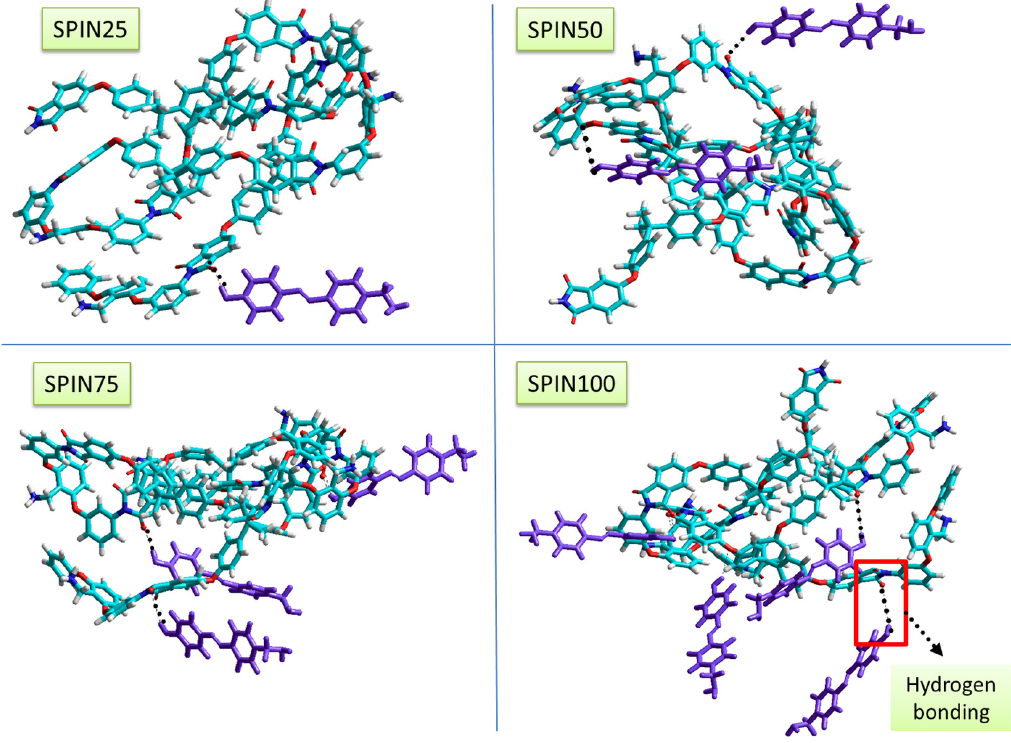
Figure 2. Geometry optimization (at minimal energy) of each PI-based supramolecular system (tube shape) containing various amounts of AzoCN. The PI (4 structural units) and AzoCN interact via hydrogen bonding. Colors: red is oxygen, cyan is carbon, withe is hydrogen, blue is nitrogen, and violet is AzoCN chromophore.